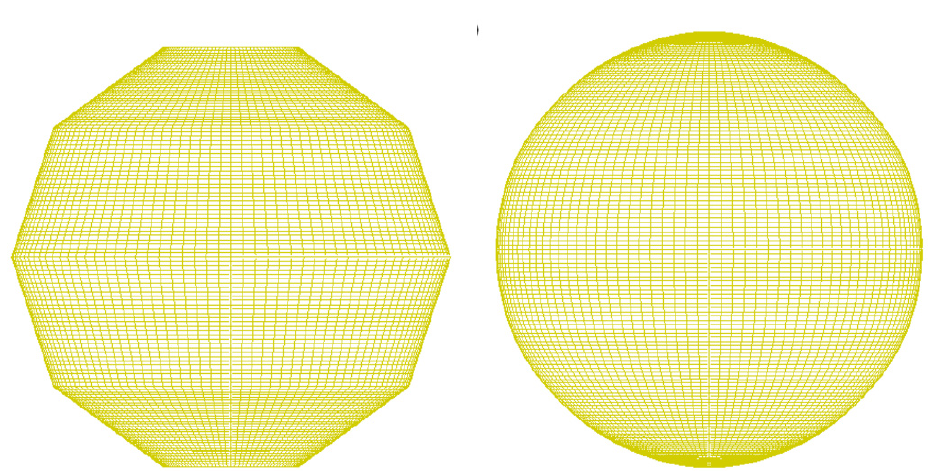
Figure 9. Mesh generation of the shell: (left) before forming; (right) after forming.